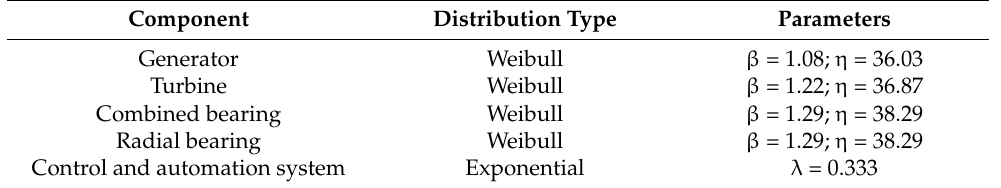
Table 2. Parameter values of the mean time to repair (MTTR) distributions of the considered compo-